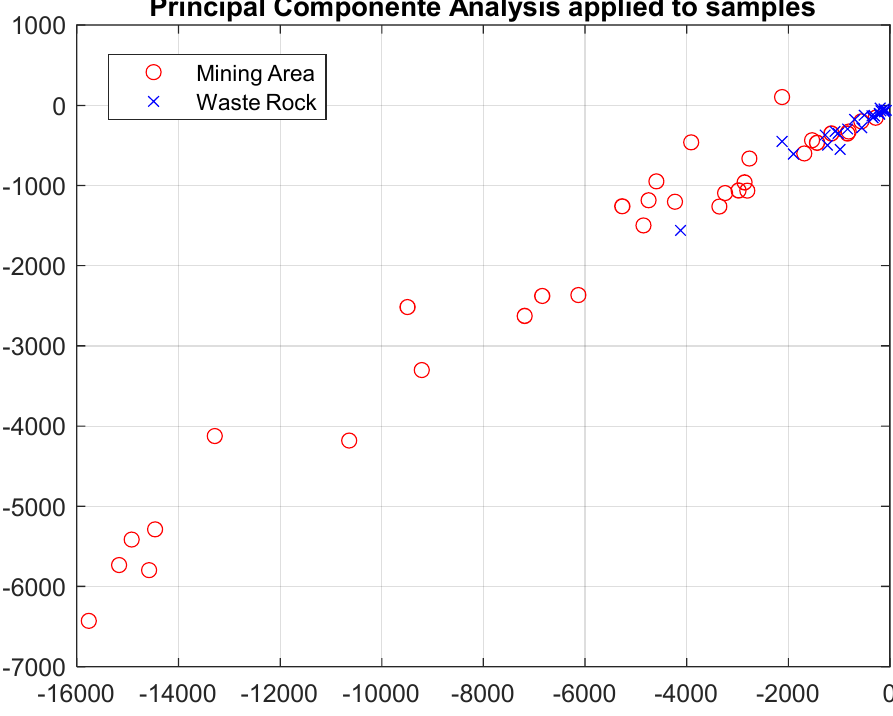
Figure 8. PCA—Projection of samples in the plane defined by the two main principal components. The principal component analysis was also applied to the variables through a loading plot (Figure 9) using the software AnDad [27].